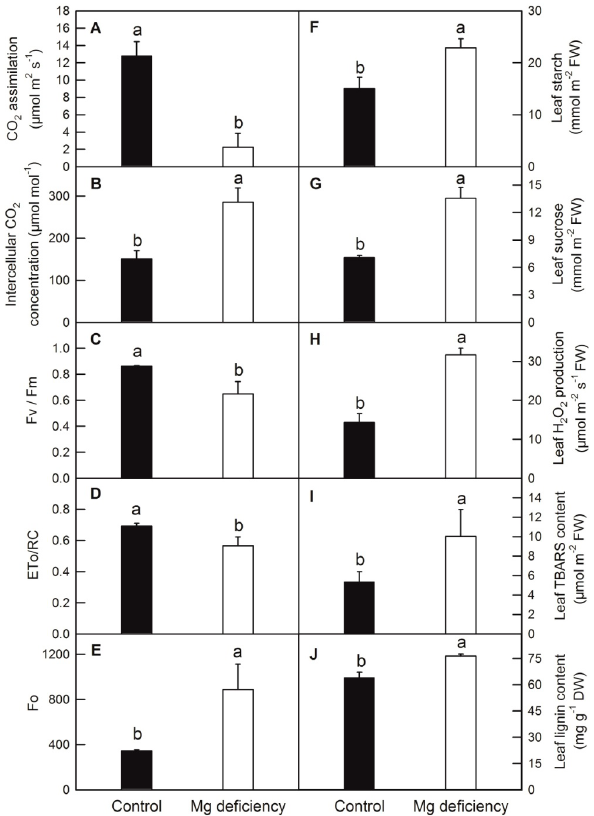
Figure 3. Effects of Mg deficiency on CO 2 assimilation ( A ), intercellular CO 2 ( B ), maximum quantum yield of primary photochemistry (Fv/Fm) ( C ), electron transport flux per reaction center at t = 0 (ET o /RC) ( D ), minimum fluorescence (F o ) ( E ), leaf starch ( F ), sucrose ( G ), H 2 O 2 production ( H ), TBARS ( I ) and lignin ( J ) content in C. sinensis . Bars represent means ±SD ( n = 4). Difference among the treatments was analyzed by student’s t -test. Different letters indicate a significant difference at p < 0.05.